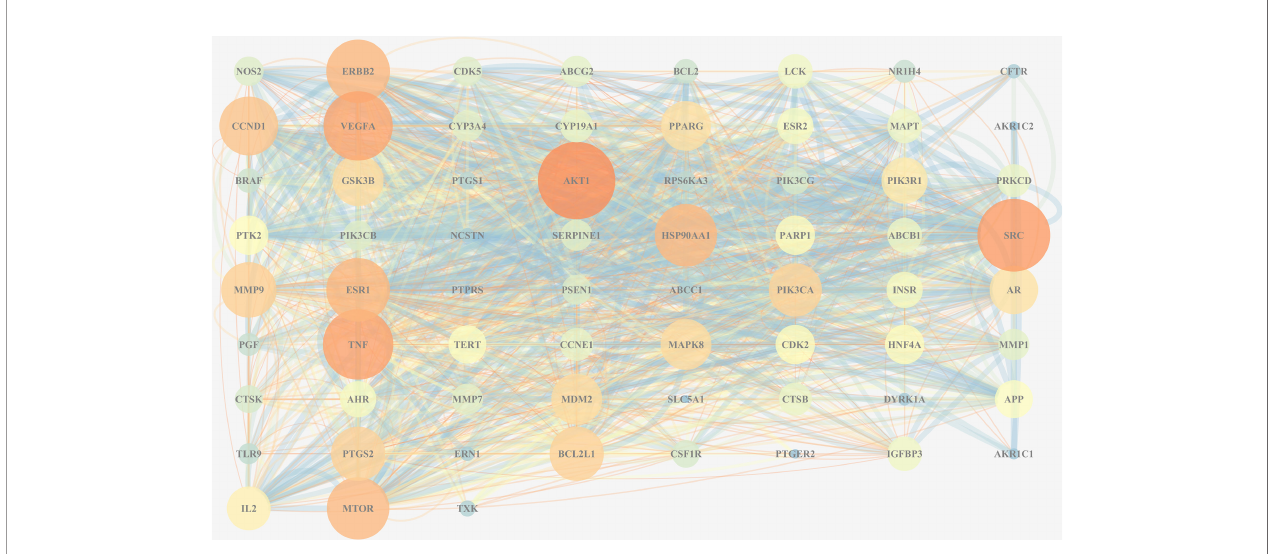
FIGURE 7 | The PPI network of all overlapped targets. The size of nodes represents their degree values, and the width of edges represents interactions between the nodes. The color represents their degree values and combined scores, which changes from blue to orange represent values from low to